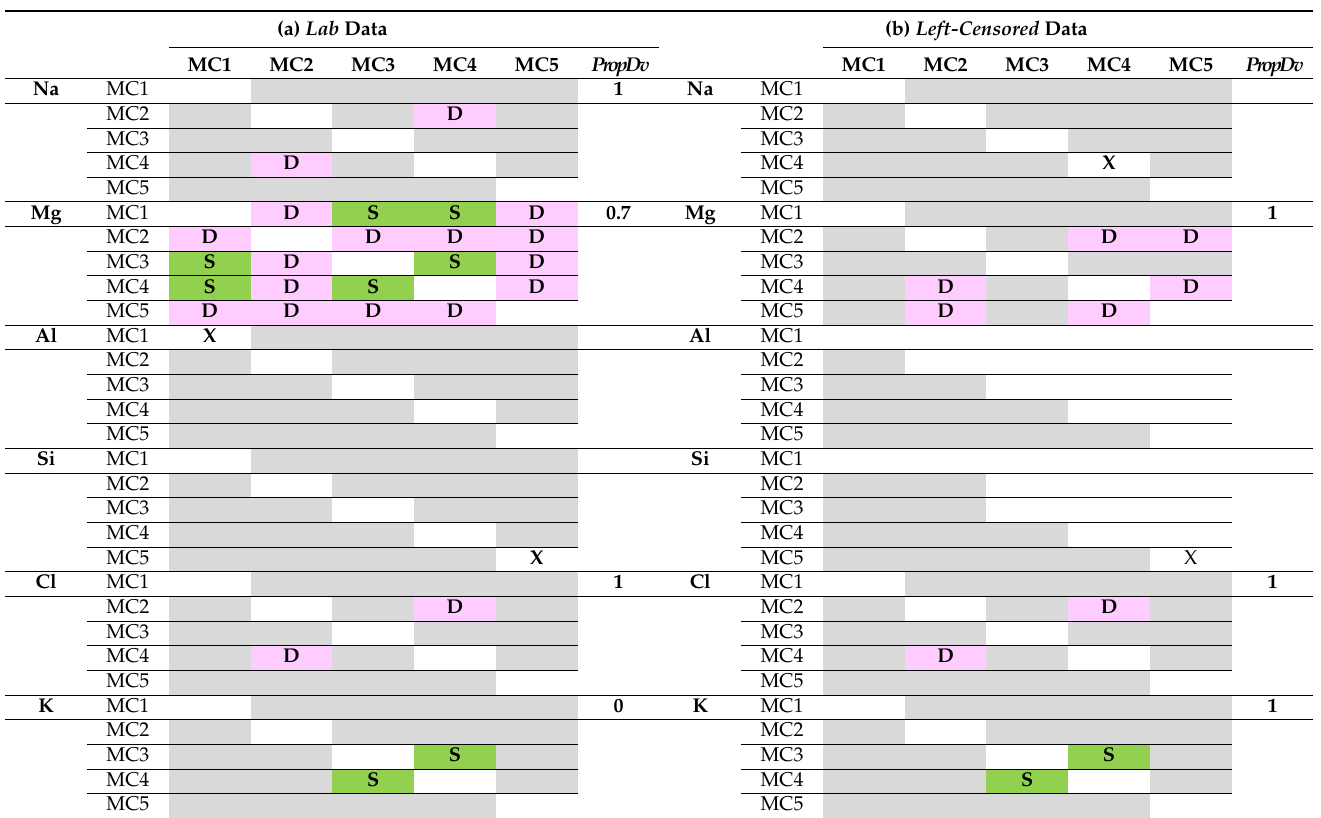
Table 3. Differences (D, pink) or similarity (S, green) in the descriptors medians between morpho- chemical groups, based on Mann–Witney U criterion ( p ≥ 0.05). propDv : proportion of differ- ences per descriptor. propDg : proportion of differences per morpho-chemical group. (a): Lab data. (b): left-censored data. Grey: not taken into